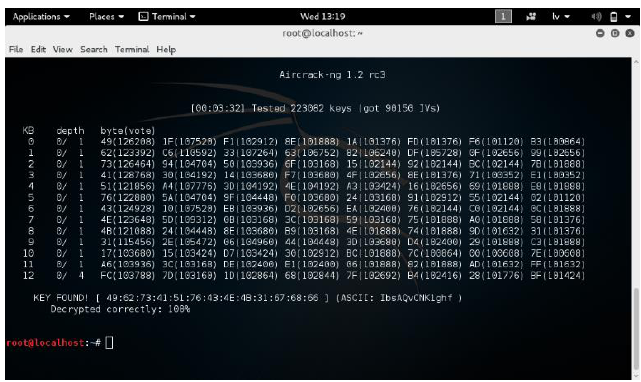
Fig. 4. Screenshot of Kali Linux terminal emulator with the acquired WEP key using aircrack-ng.